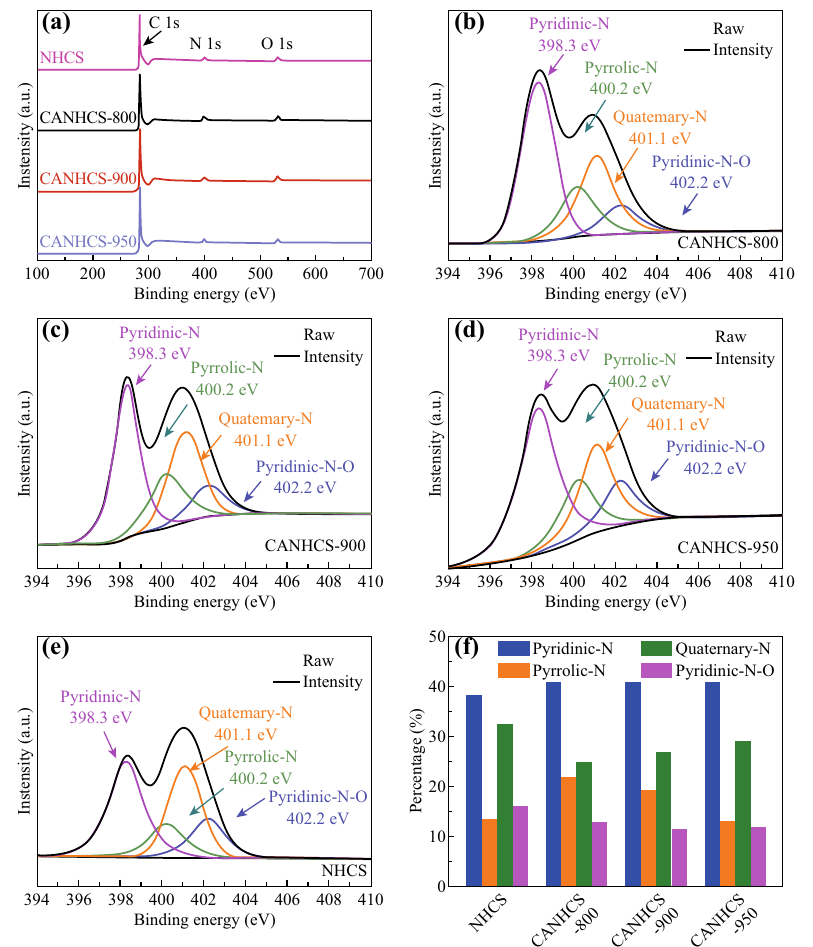
Fig. 6 a XPS spectra of NHCSs, CANHCS-800, CANHCS-900 andCANHCS-950, b – e high-resolution XPSanalysis of N 1sfor b CANHCS-800, c CANHCS-900, d CANHCS-950 and e NHCSs. f relative atomic percentage (%) of different N functionalities received from the N 1s